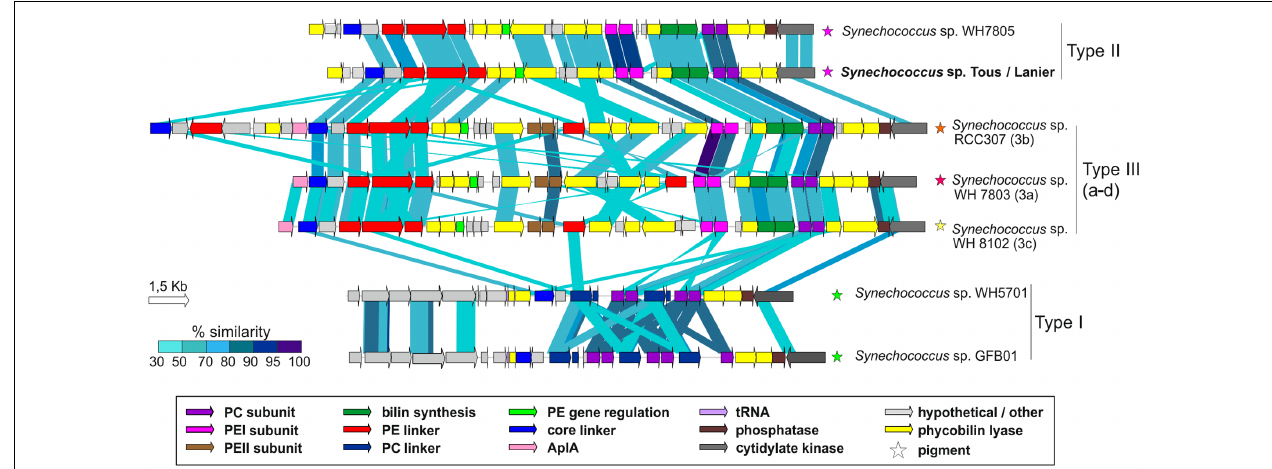
FIGURE 5 | Structure and similarity of the PBS gene cluster among marine and Tous/Lanier freshwater Synechococcus sp. Comparison made with TBLASTX with > 30% similarity hits and 150 bp alignment lengths. PC, Phycocyanin; PE, Phycoerythrin; AplA, Allophycoyanin-like protein; Phycobilin lyases, CpeY, CpeZ, CpeF, CpeS, CpeT, CpeU, RpcG, RpcE, RpcE, RpcF, RpcT; Bilin synthesis, pebA, pebB.